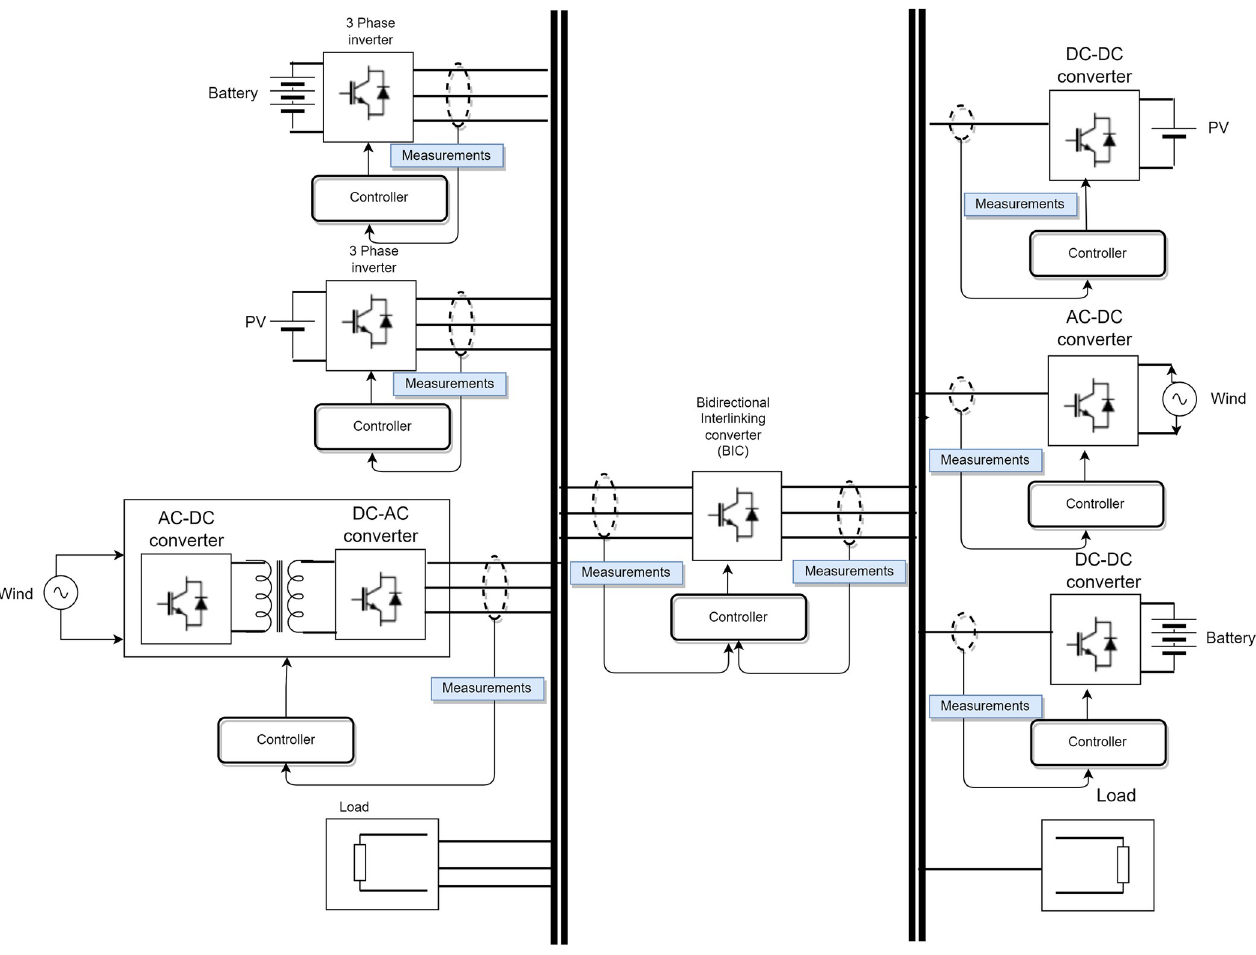
Fig 1. Hybrid microgrid with RES and loads